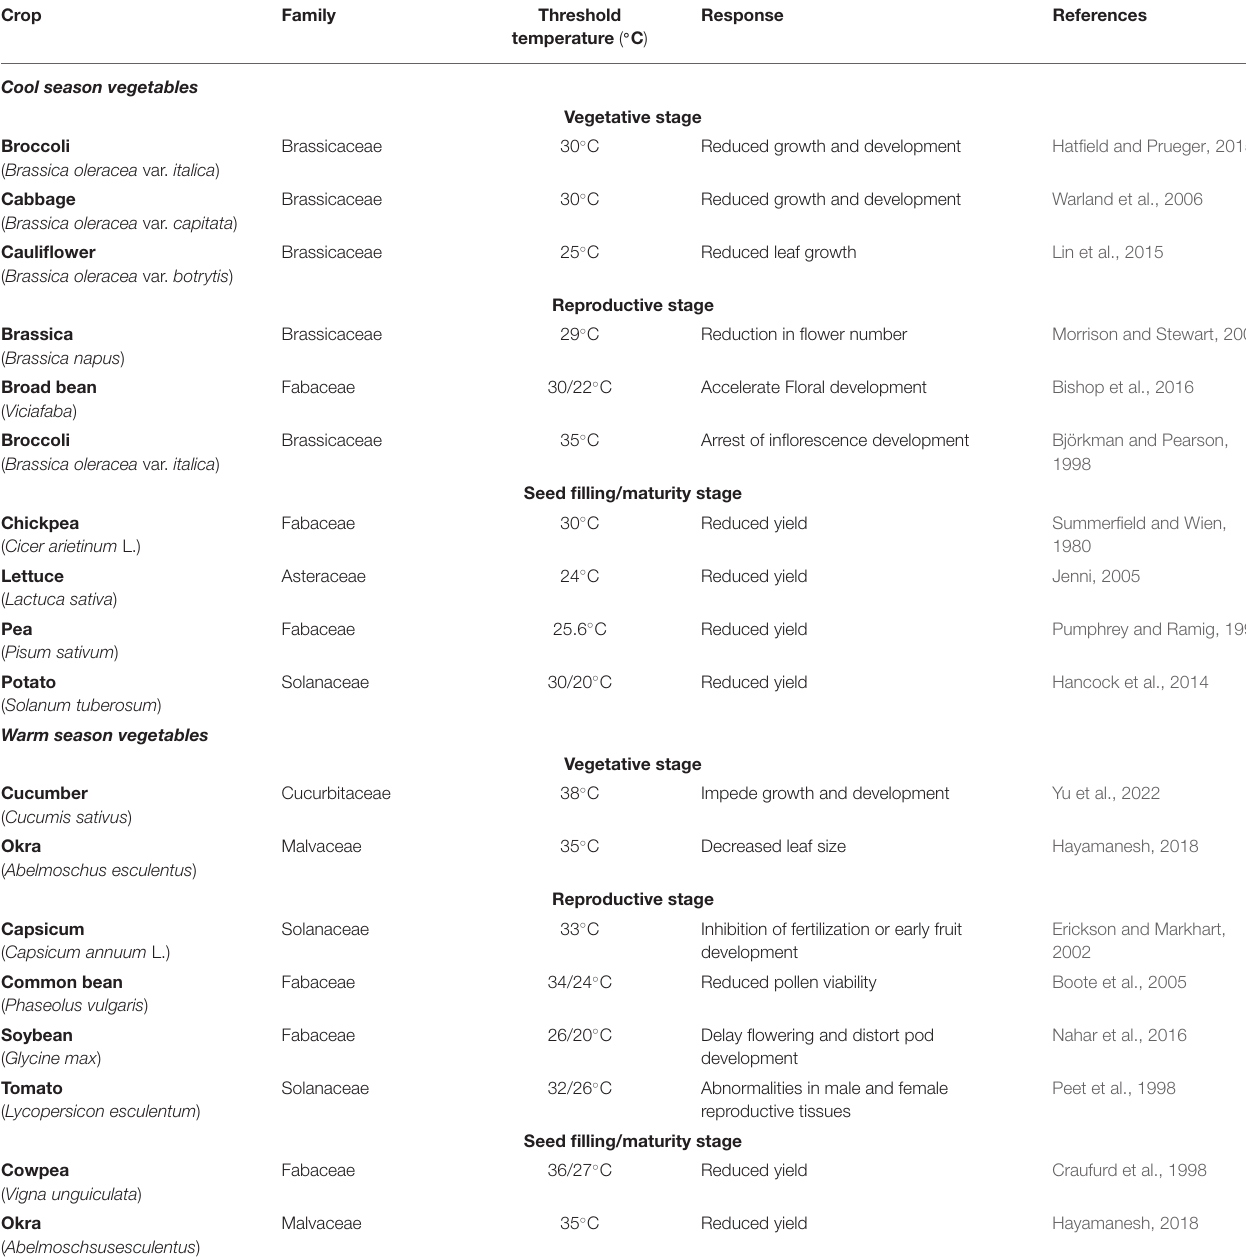
TABLE 1 | Threshold temperature for some vegetable crops at different stages of plant development.